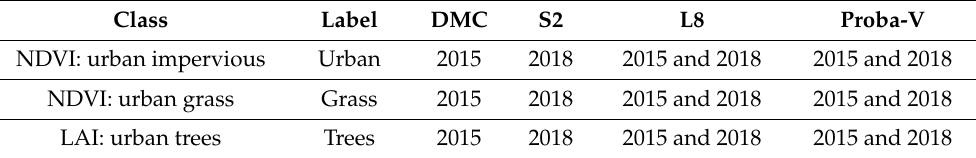
Table 4. Datasets used in the SONIA